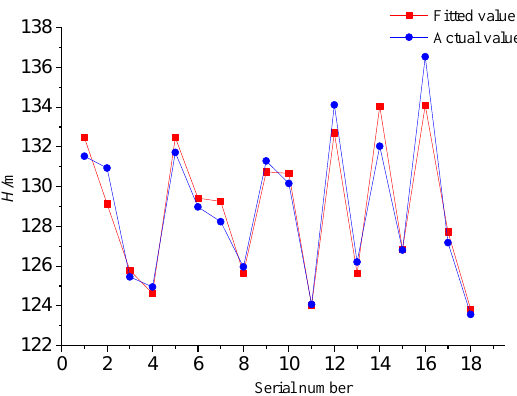
Figure 5. Comparison of fitted value and actual value for the head .